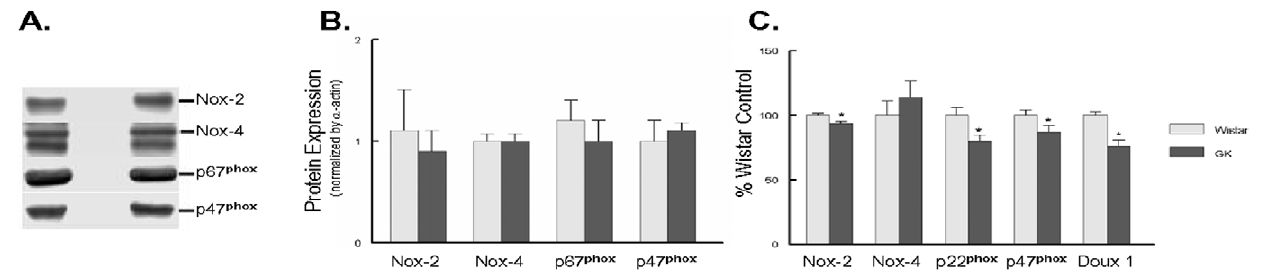
Figure 6. Diabetes did not significantly alter NOX protein expression. A. Representative western blot, B. Quantification of western blot data normalized to alpha-actin. No differences were observed between the GK and Wistar groups. C. QRT-PCR of aortic-mRNA. Values are mean 6 SEM of 4–7 animals. * p , .05 compared to Wistar.